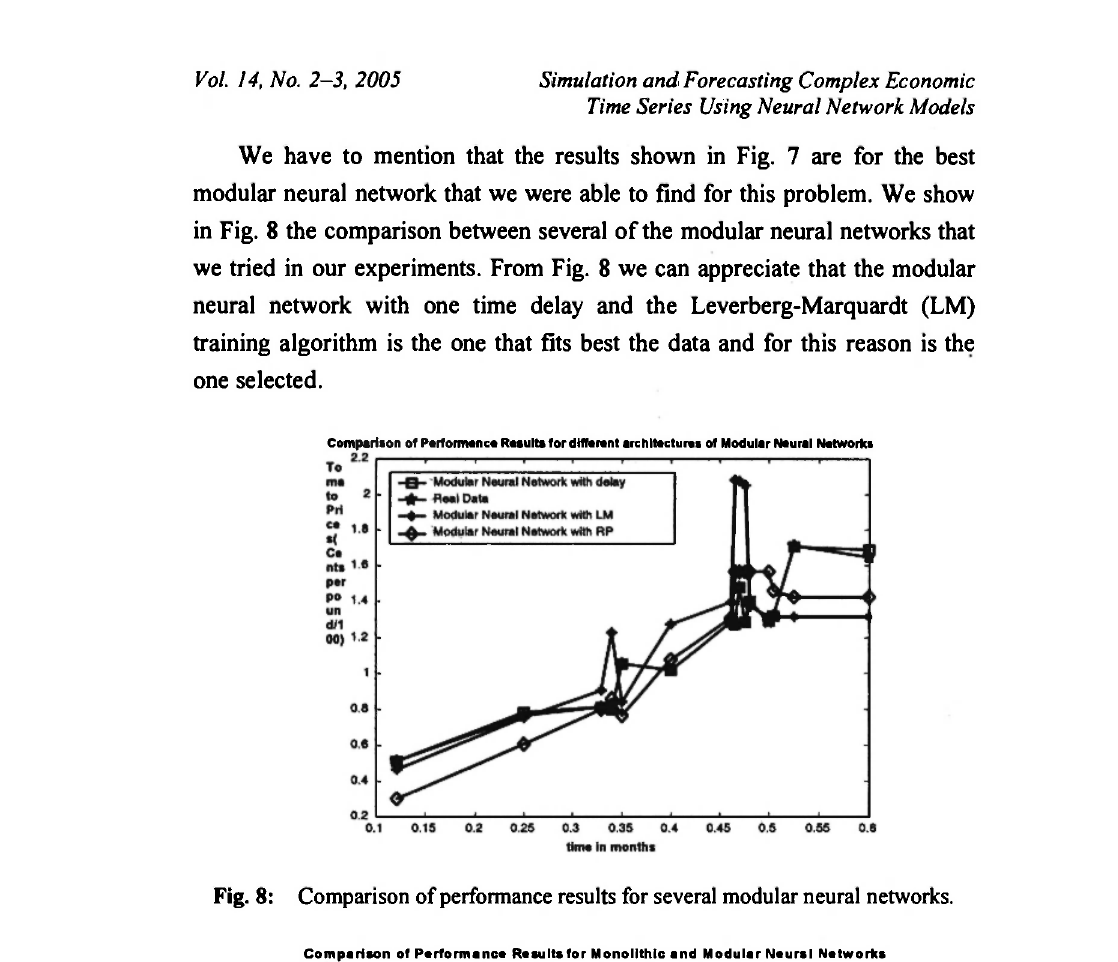
Fig. 8: Comparison of performance results for several modular neural networks.